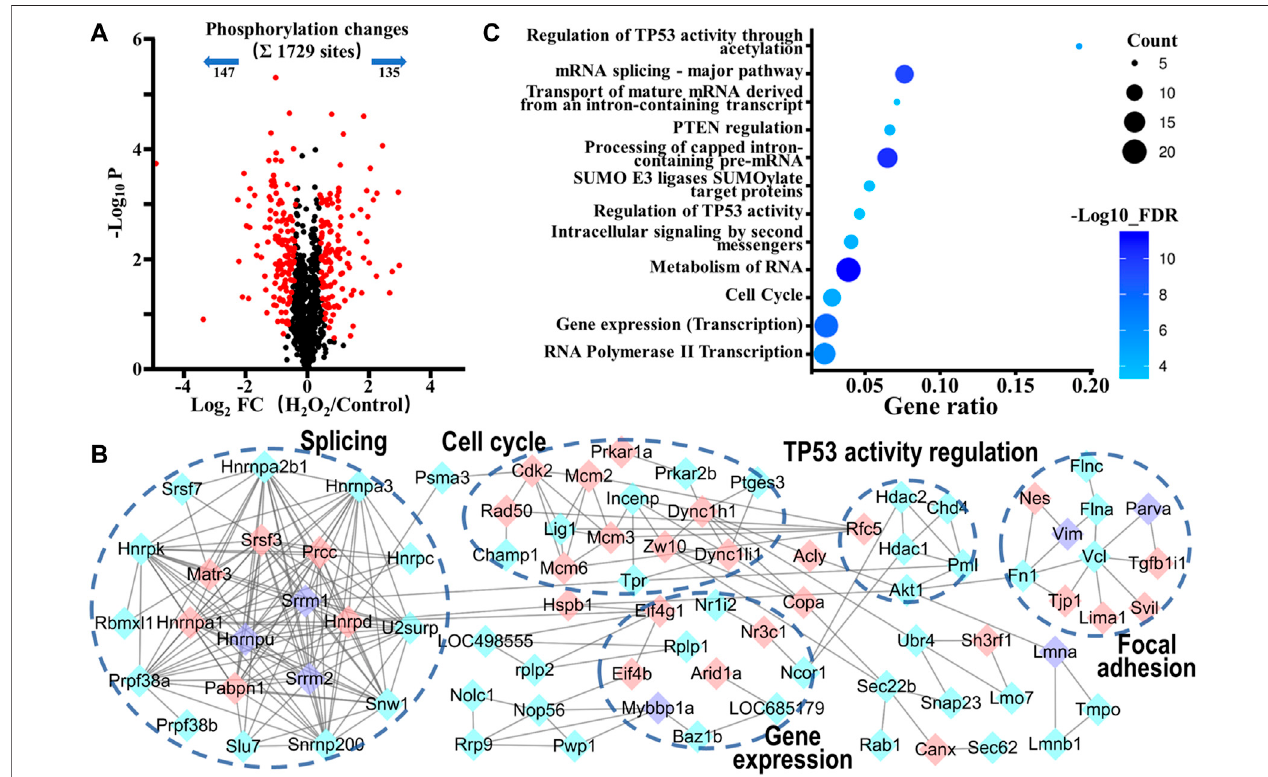
FIGURE 4 | Phosphoproteomic analysis of the action mechanism of oxidative stress-induced apoptosis in VSMCs. (A) A volcano plot showed that 282 localized phosphorylation sites changed signi fi cantly (FDR < 0.05, S0 of 0.5) upon H 2 O 2 treatment. (B) Protein-protein interaction map of phosphoproteins whose sites were signi fi cantly changed upon H 2 O 2 treatment (STRING combined interaction score > 0.7). Pink nodes represented their phosphorylation sites were upregulated, blue nodes represented their phosphorylation sites were downregulated, while purple nodes had both upregulated and downregulated phosphorylation sites. (C) The Gene Ontology- (GO-) based Reactome pathways enrichment of the altered